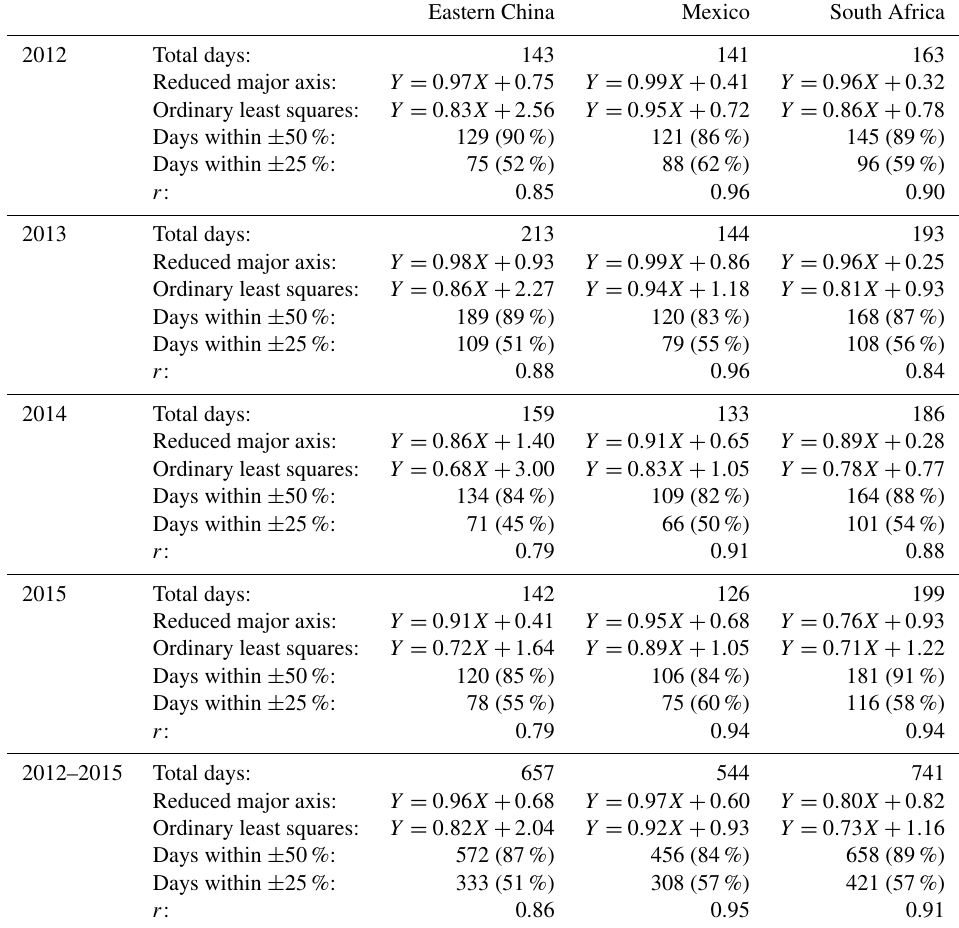
Table 3. The total number of days with valid SO 2 for both OMI and OMPS for each year. Number of samples within ± 50 and ± 25% agreement and percentage of the total sample, temporal correlation coefficient ( r ), and the slopes and intercepts from reduced major axis fitting and ordinary least-squares fitting for each year and all years. X represents OMI SO 2 and Y represents OMPS SO 2